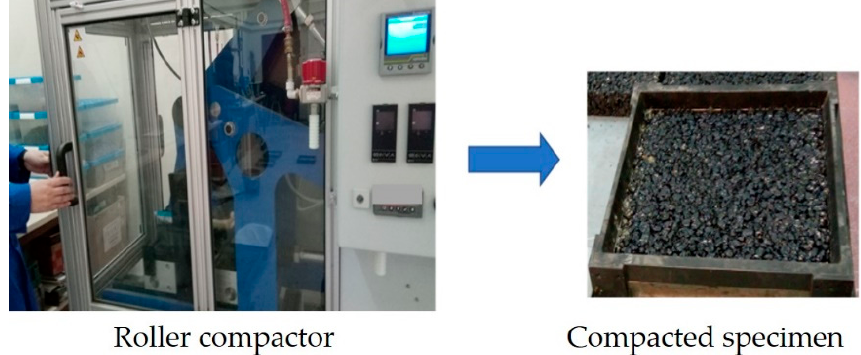
Figure 4. Roller compactor device ( left ) and a compacted specimen ( right